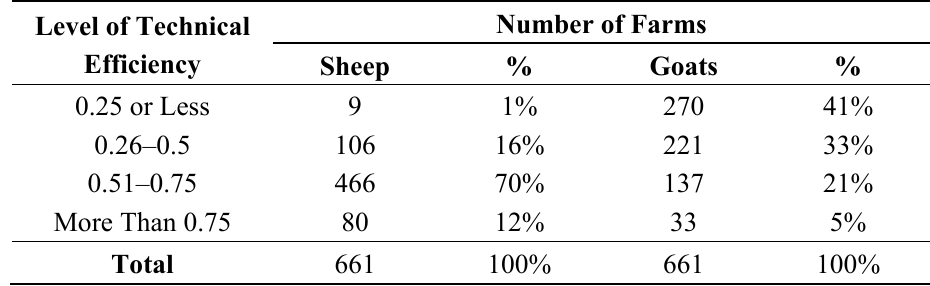
Table 7. Number of sheep and goats farms at different levels of technical